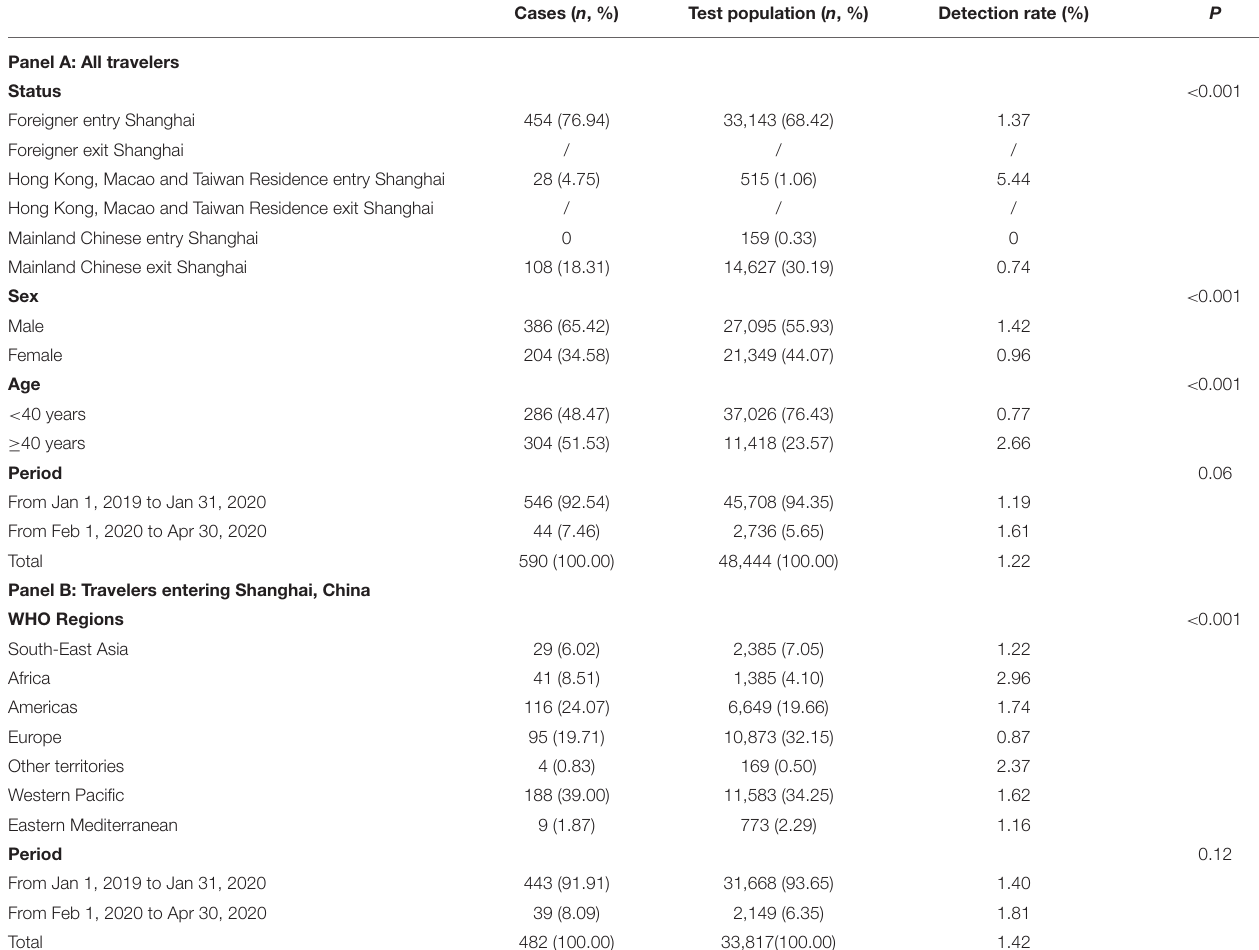
TABLE 1 | Characteristics of infectious diseases among travelers at Shanghai Port, China, Jan 2019–Apr 2020. Cases ( n , %) Test population ( n , %) Detection rate (%)